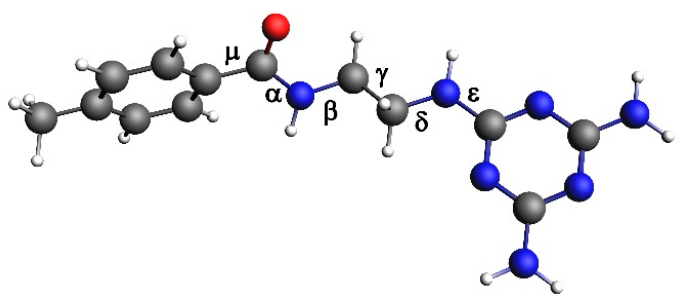
Figure 1. Labeling of the bonds for which the PES scan has been performed. µ represents the bond with the meso substituent.